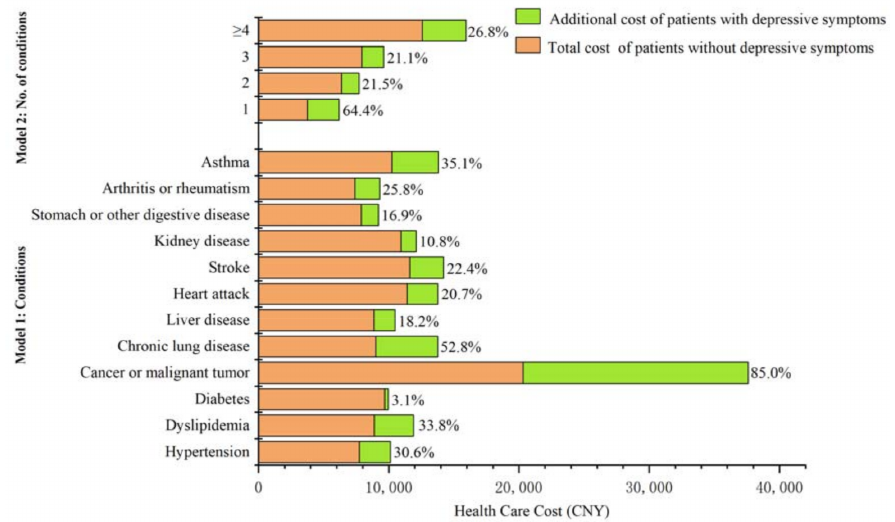
Figure 1. Comparing the proportion of additional health care costs to the total costs of patients without depressive symptoms. Note: The data details used in drawing Figure 1 are shown in Table A2.